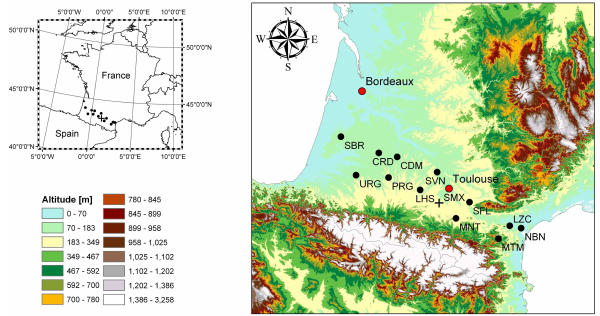
Fig. 2. SMOSMANIA stations in southwestern France (black dots), forming a 400km transect between the Atlantic Ocean and the Mediterranean sea. The + symbol is for the SMOSREX